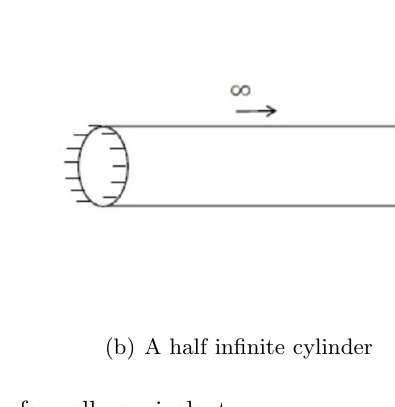
Figure 20 . (a) and (b) are conformally